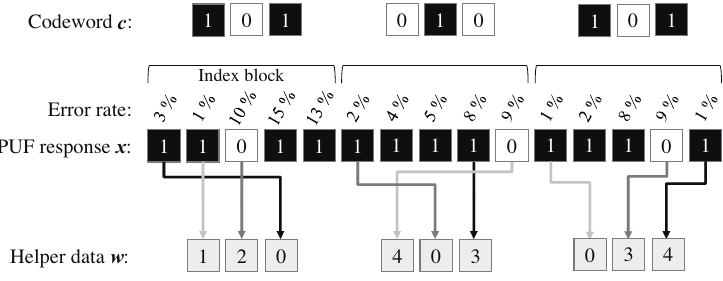
Figure 6: Example of enrollment with